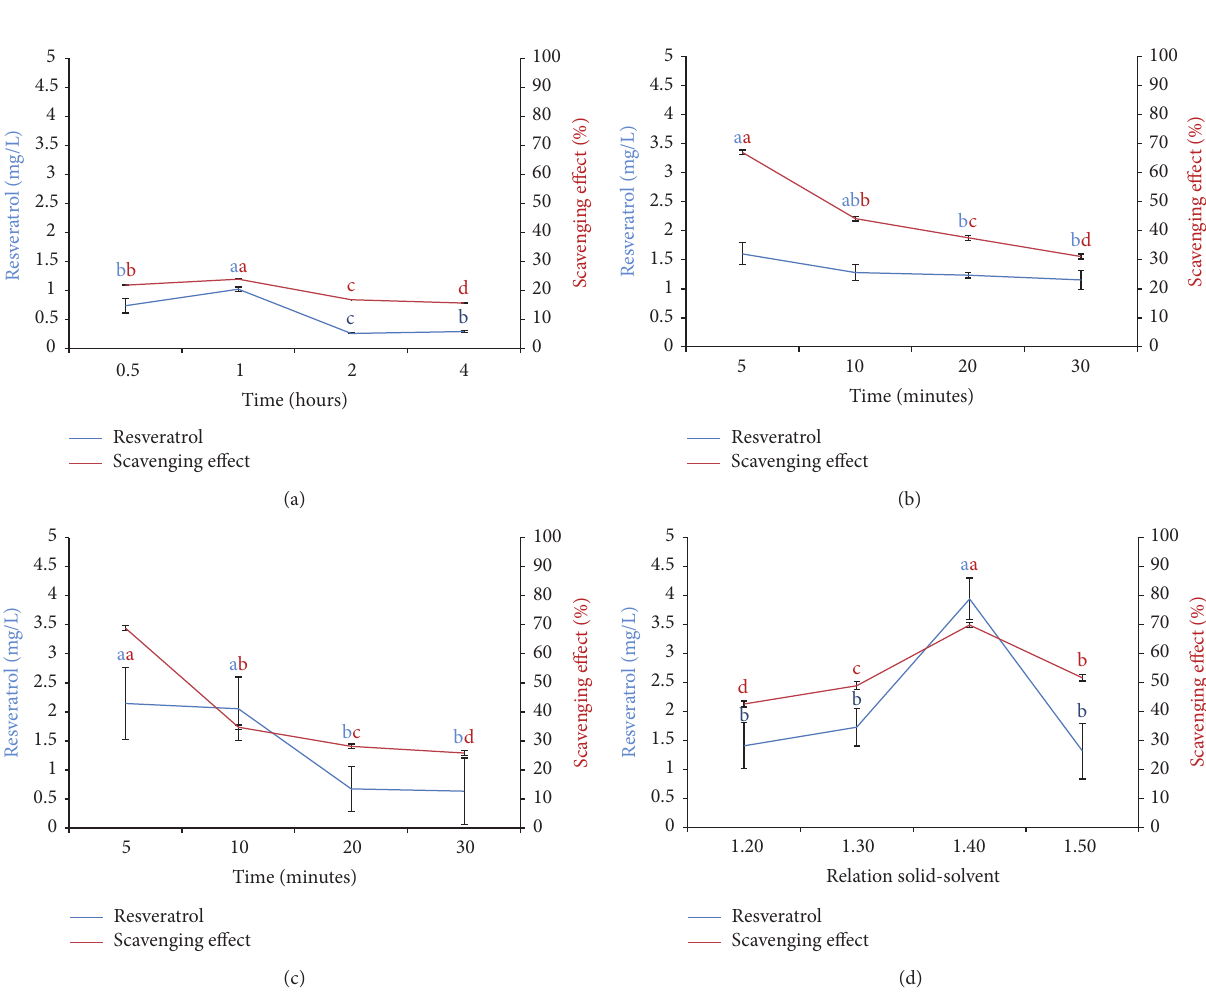
Figure 1: (a) Effect of the time exposure efficiency on the 𝑡 -resveratrol contents in extracts obtained by maceration with 80% methanol (0.1g per 4mL), correlated to the radical-scavenging activity. (b) Effect of the resveratrol contents in extracts obtained by ultrasound with 80% methanol (0.1g per 4mL) correlated to the radical-scavenging activity. (c) Effect of the time efficiency maceration before treatment on the resveratrol contents in extracts obtained by maceration with 80% methanol (0.1g per 4 mL) previously exposed to ultrasound for 5 minutes, correlated to the radical-scavenging activity. (d) Correlation of resveratrol contents in extracts at different proportions of solid- solvent, obtained by ultrasound, correlated to the radical-scavenging activity. Means ± standard error followed by the same letter are not statistically different at 𝑝 = 0.05 , Tukey-Kramer